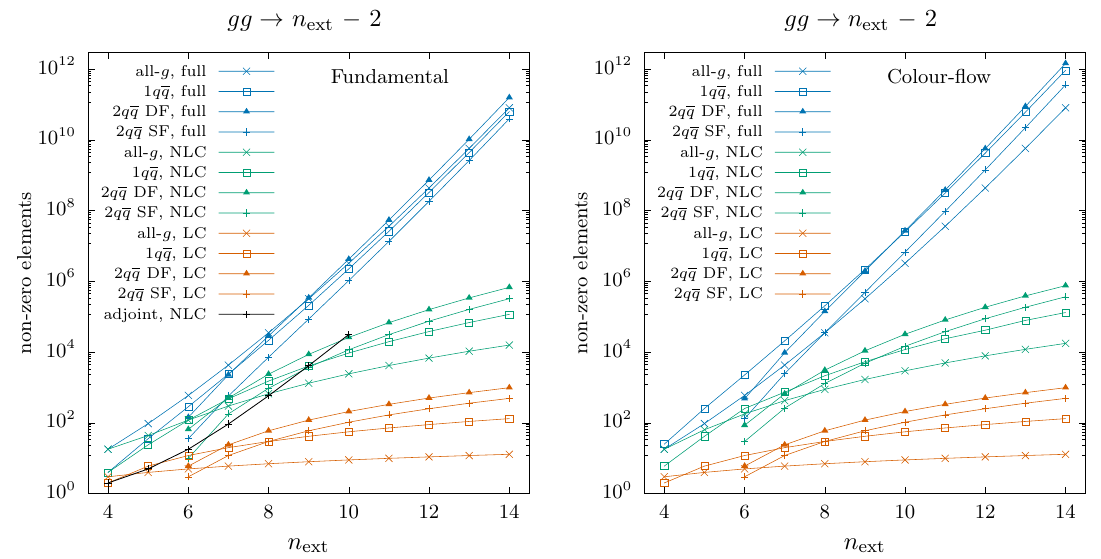
Figure 2 . Number of non-zero elements in the colour matrix at LC (red), NLC (green) and full colour (blue) for gg initial state in fundamental (left) and colour-flow decomposition (right) for various channels: all-gluon (cross), one-quark-pair (box), two-quark-pair distinct-flavour (triangle) two-quark-pair same-flavour (bar). In the left figure is also shown the number of non-zero elements in the adjoint decomposition at NLC accuracy up to 10 external